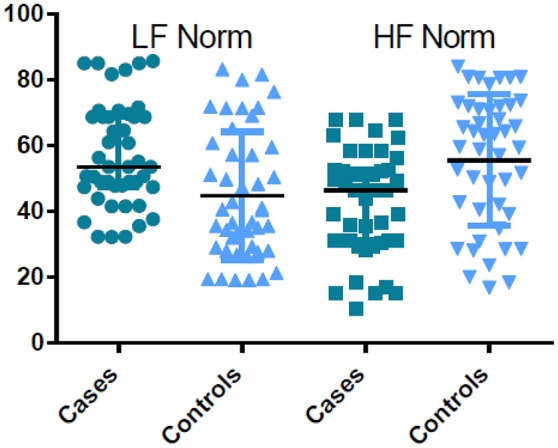
Comparison of LF norm and HF norm between the cases and controls.